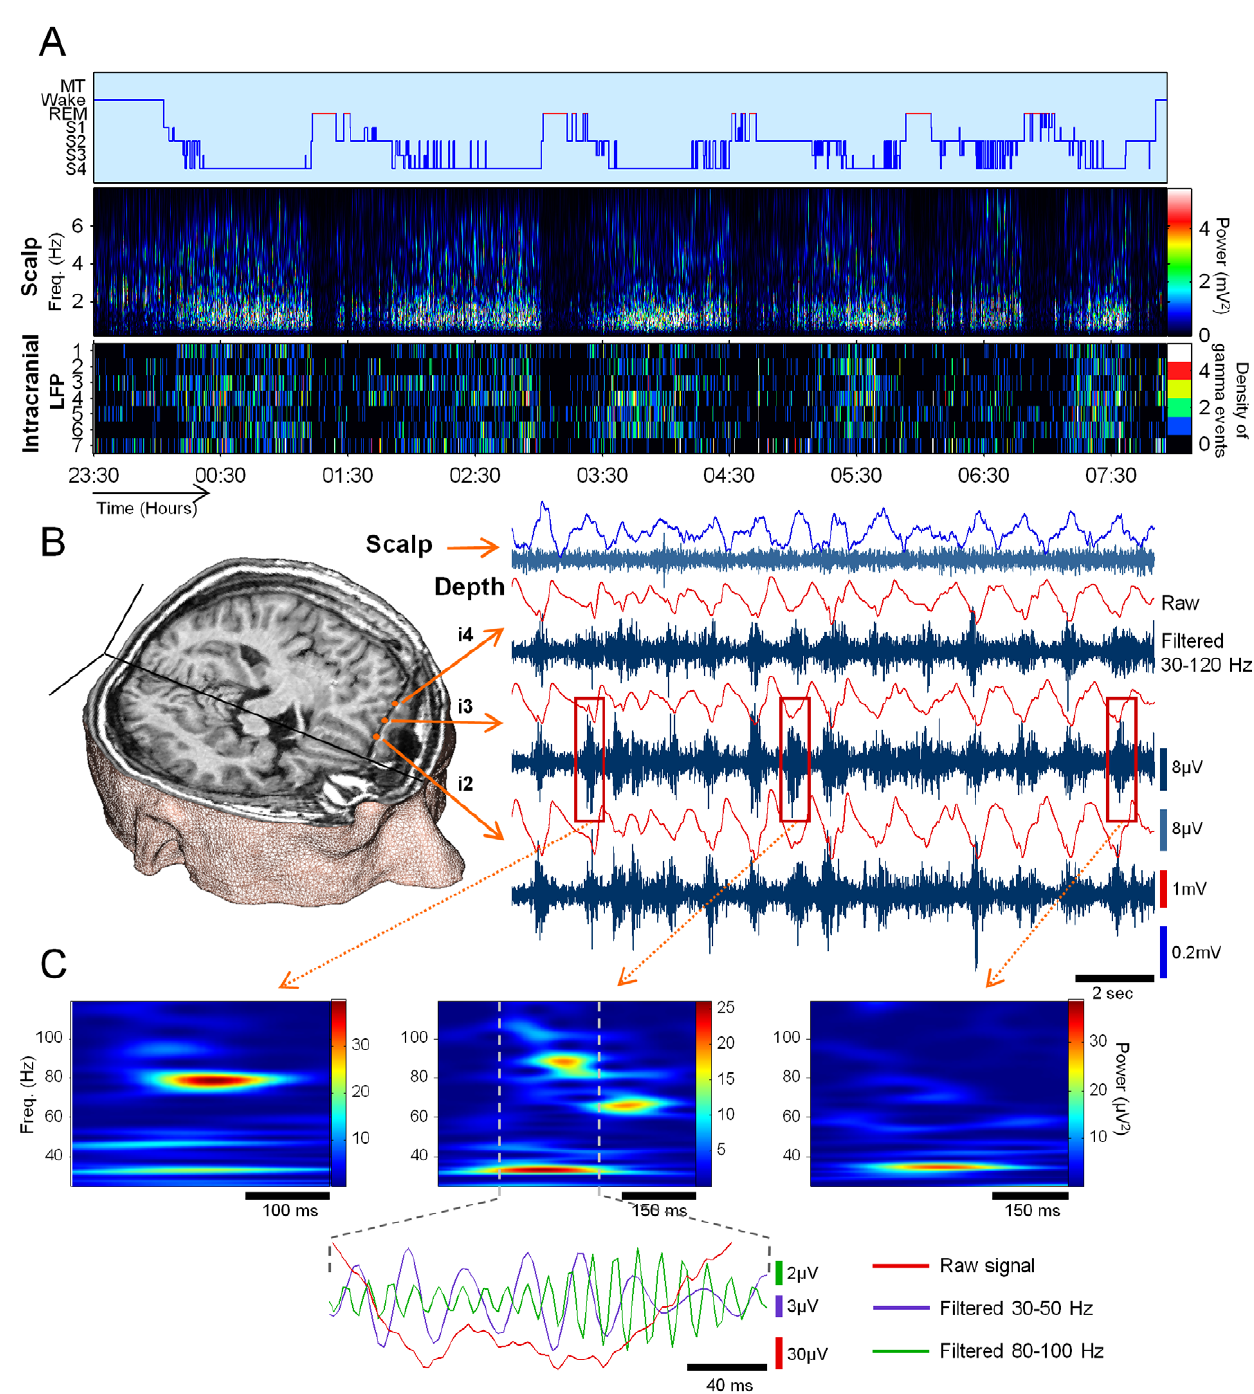
Figure 2. Gamma oscillations recorded with intracranial electrodes during SWS. ( A ) All-night hypnogram of a representative subject ( P15 ) ( Top ), time-frequency evolution of the power for one scalp electrode ( Middle ), density of gamma events (30–120 Hz) detected on seven intracranial contacts located in the frontal and temporal cortex ( Bottom ). ( B ) 3D MRI reconstruction of the patient’s brain presenting one depth electrode and its corresponding 6 intracranial contacts in the left orbito-frontal gyrus ( Left ). Simultaneous recordings during deep sleep (S4 stage) showing raw and 30–120 Hz filtered activities (presented below each raw one) for one scalp (FP1) and three depth contacts in the same cortical region ( Right ). ( C ) Time-frequency representations of the three bursts of gamma activity shown in ( B ) illustrating examples of pure oscillations with a narrow frequency in the high gamma range ( Left ), the low gamma range ( Right ), and complex oscillations composed of a few mixed low and high frequencies ( Middle ), as also shown in the filtered signals ( Bottom ).